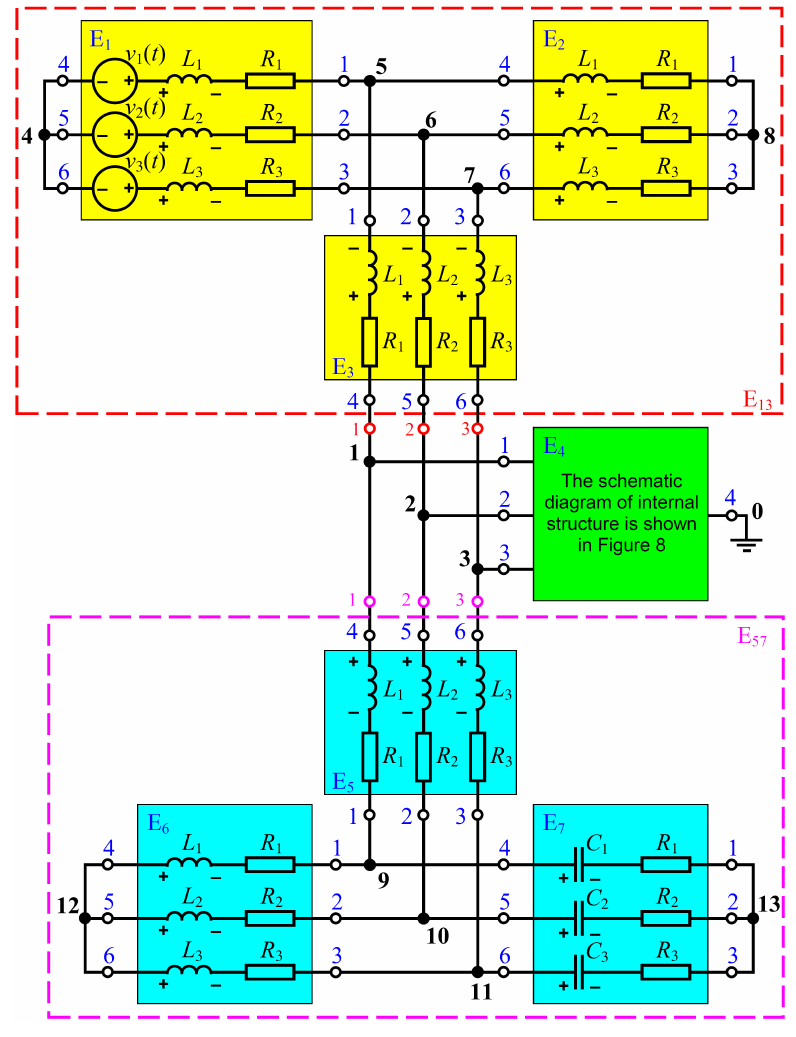
Figure 12. The equivalent diagram of a fragment of a MV power distribution network with distributed generation in one phase. Table 3. Parameters of the structural elements of the modeled electrical